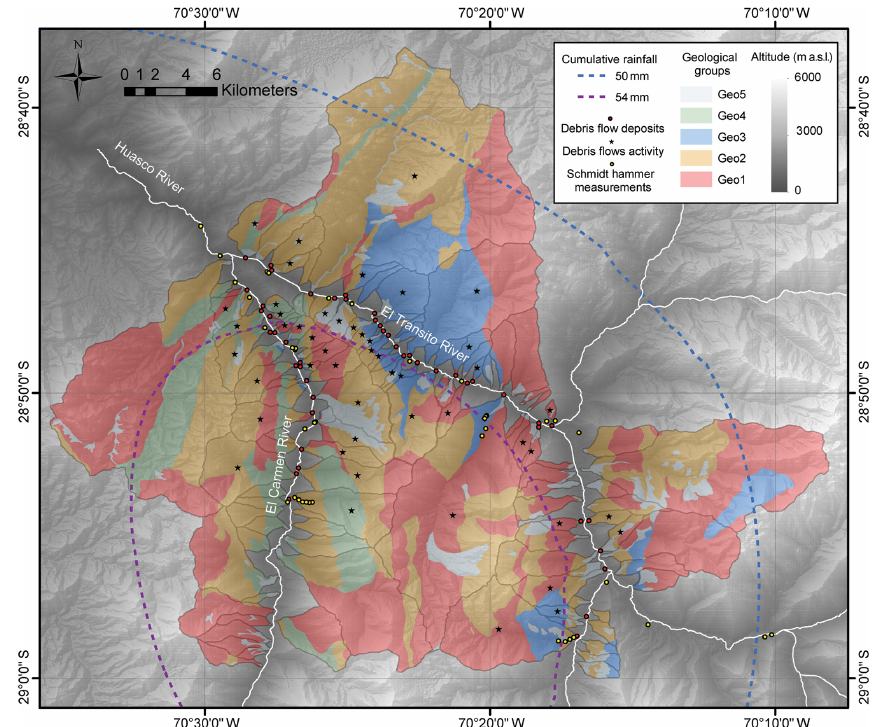
Figure 2. Map that shows the distribution of geological groups defined in the Huasco River valley after Salazar et al. (2013) with the location of Schmidt hammer stations. The map includes the distribution of debris flow deposits during March 2015 and isohyets of accumulated rains created by kriging interpolation of meteorological data during the storm. Topography extracted from a digital elevation model courtesy of NASA JPL Caltech with a nominal spatial pixel resolution of 30m × 30m (https://asterweb.jpl.nasa.gov/gdem.asp, last access: 6 May